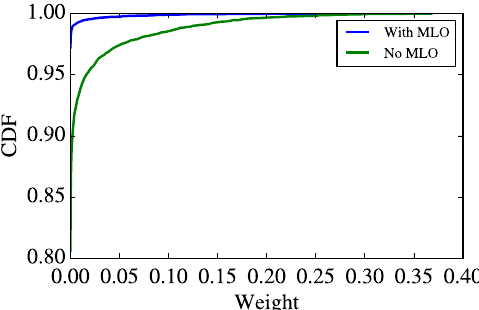
Fig. 13. CDFs of BFMC’s weight distributions when MLO was and was not